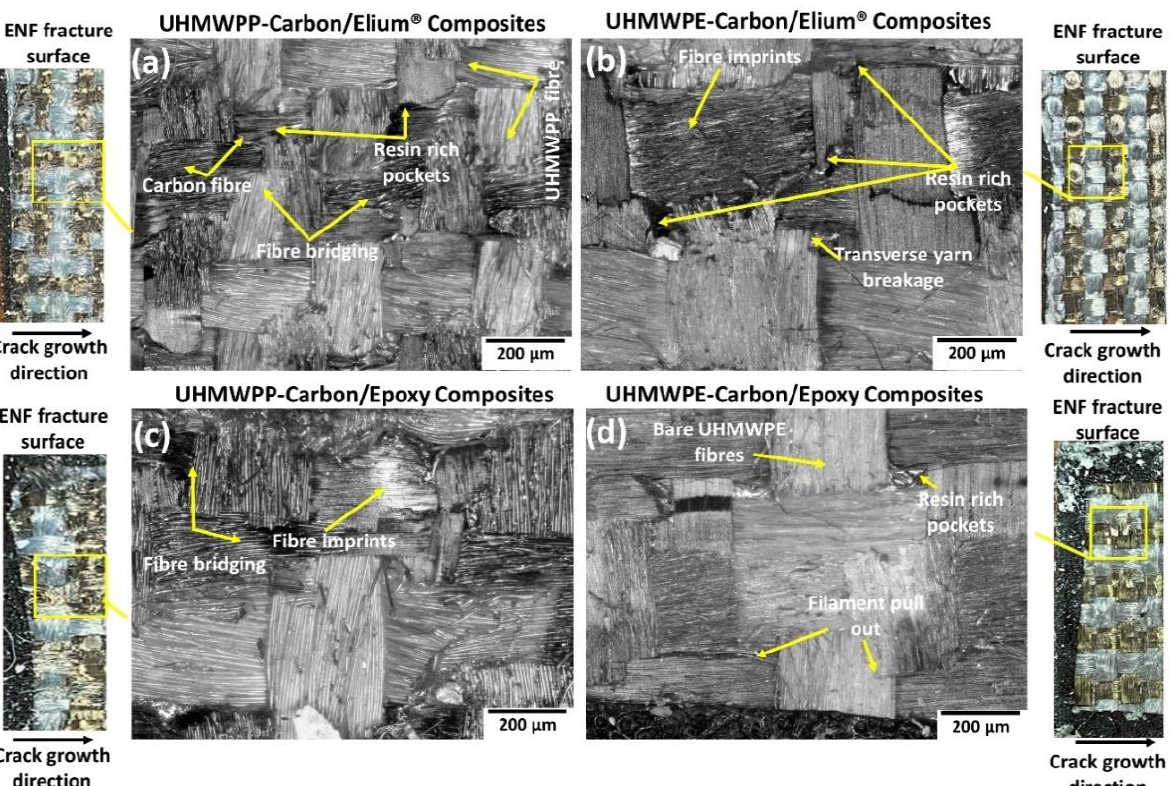
Figure 19 . Micrographic images of the failed surfaces of ( a ) Carbon_UHMWPP/Elium ® ( b ) Car- bon_UHMWPE/Elium ® ( c ) Carbon_UHMWPP/Epoxy and ( d ) Carbon_UHMWPE/Epoxy reinforced composite configurations under Mode II loading